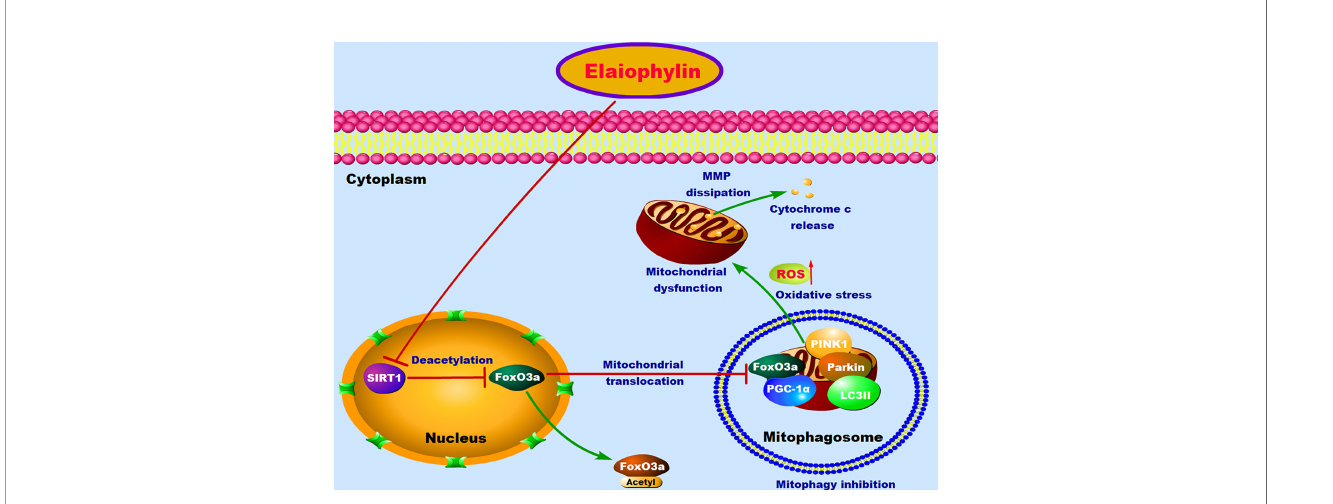
FIGURE 7 | The proposed molecular mechanism of Elaiophylin in killing UM cells. In normal condition, FoxO3a deacetylated by SIRT1 results in its translocation to mitochondria, where deacetylated FoxO3a and PGC-1 a form the FoxO3a/PGC-1 a complex. Increased formation of FoxO3a/PGC-1 a complex triggers ubiquitination and PINK1/Parkin-mediated proteasomal degradation for mitochondrial clearance. Elaiophylin treatment inhibits SIRT1-mediated mitophagy, promotes mitochondrial dysfunction and oxidative stress, which eventually leads to the death of UM